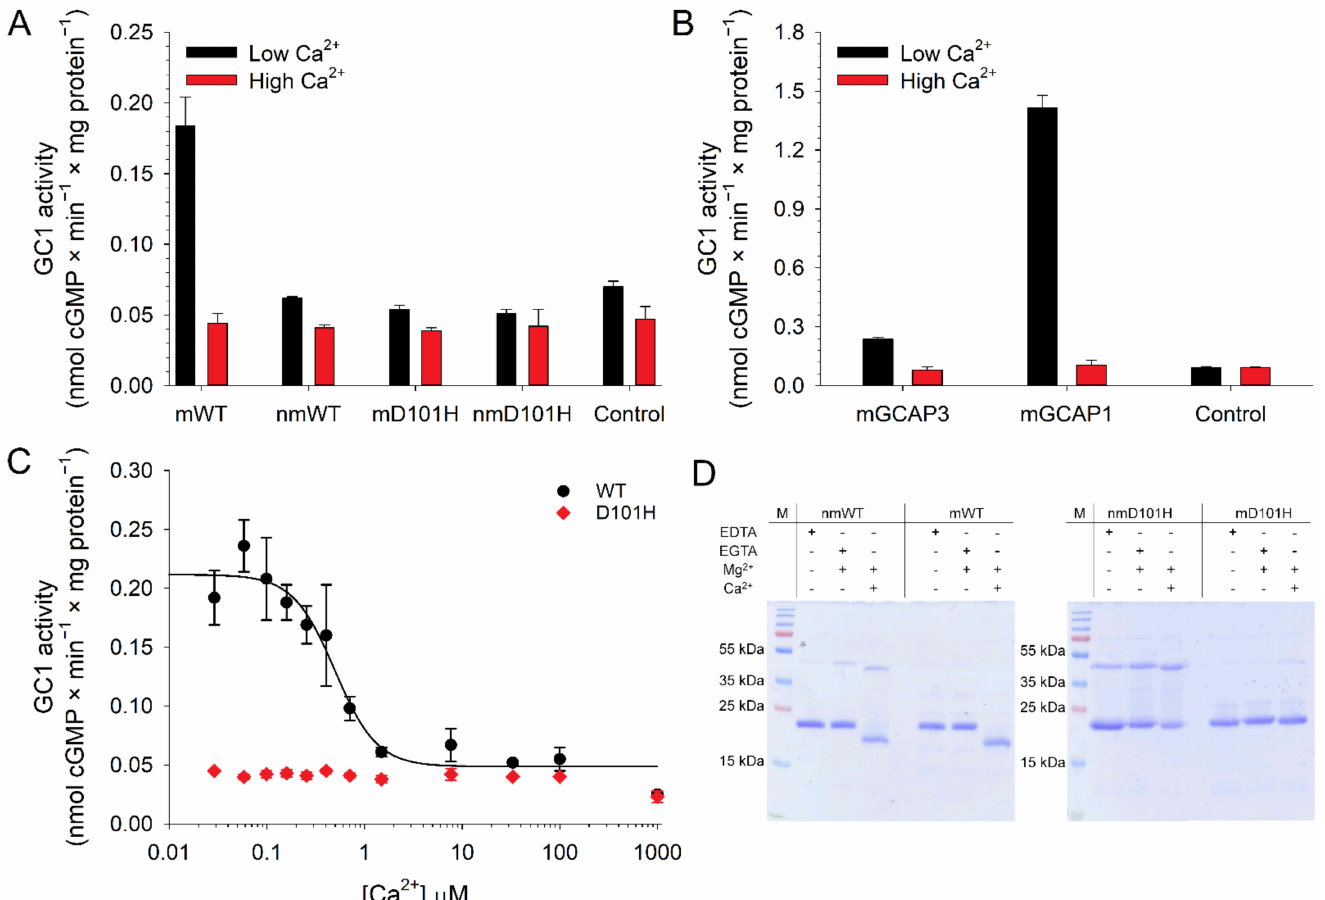
Figure 3. Regulation of human GC1’s activity and evaluation of Ca 2+ -sensitivity of GCAP3 variants. ( A ) Enzymatic regulation of human GC1 by 10 µ M GCAP3 myristoylated (m-) and non-myristoylated (nm-) variants under activating (low Ca 2+ , <19 nM, black) and inhibiting conditions (high Ca 2+ , ~30 µ M, red); ( B ) Enzymatic regulation of human GC1 by 10 µ M mGCAP3 or 5 µ M mGCAP1 under the same conditions. Control refers to the basal GC1 activity in the absence of regulators; ( C ) GC1 activity at different Ca 2+ concentrations (<19 nM–1 mM) of 10 µ M mWT (black) or mD101H (red) GCAP3; activation by mWT GCAP3 was half-maximal (IC 50 ) at 0.52 µ M; ( D ) 15% SDS-PAGE of ~7 µ g m/nm WT and D101H GCAP3 upon incubation with 5 mM EDTA, 5 mM EGTA + 1 mM Mg 2+ and 1 mM Mg 2+ + 5 mM Ca 2+